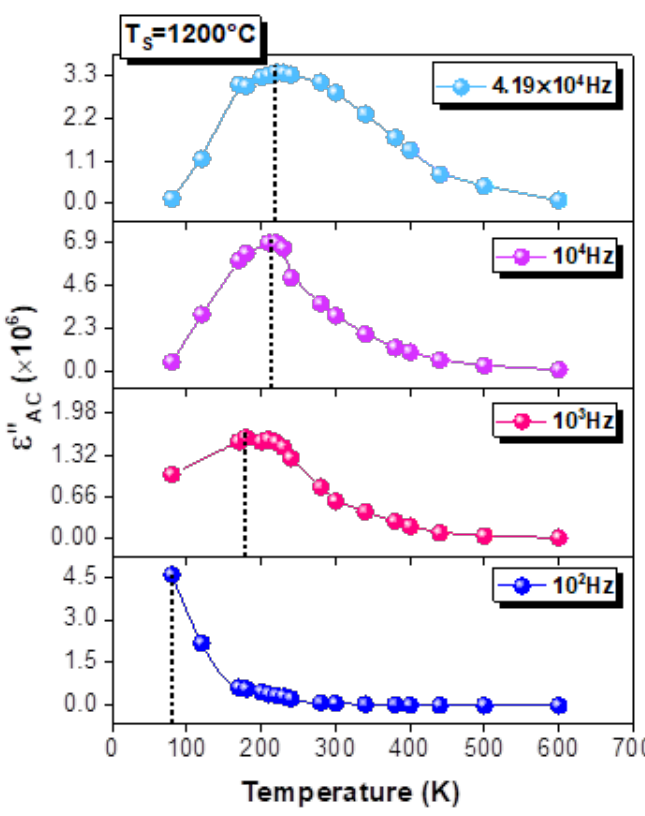
Figure 10. Temperature dependences of the imaginary part of the relative dielectric permittivity ( ε″ ) at different frequencies for the La0.9Sr0.1MnO 3 compound sintered at 1200 °C.